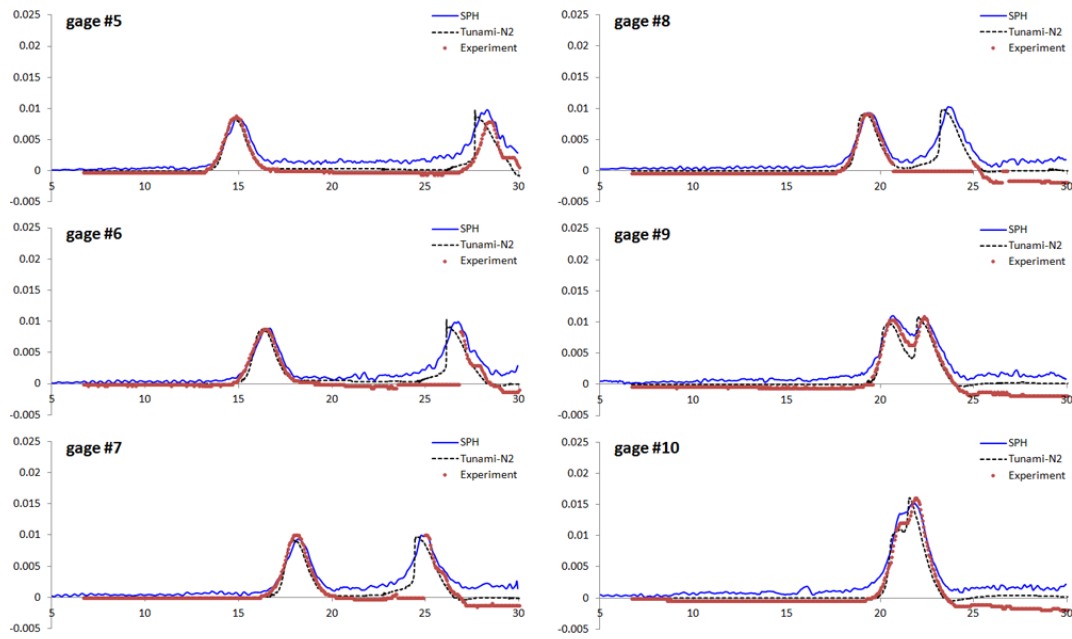
Fig. 5. Comparisons of time histories of wave height obtained from the experiment and numerical simulations at gages 5–10 of case A.